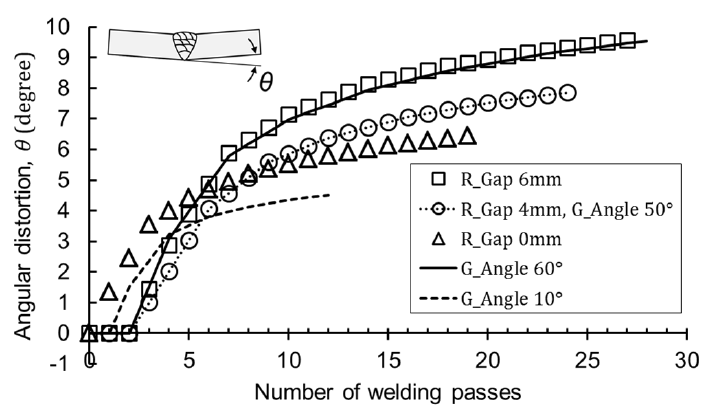
Figure 15. Calculation results with the root gap (R gap) and groove angle (G